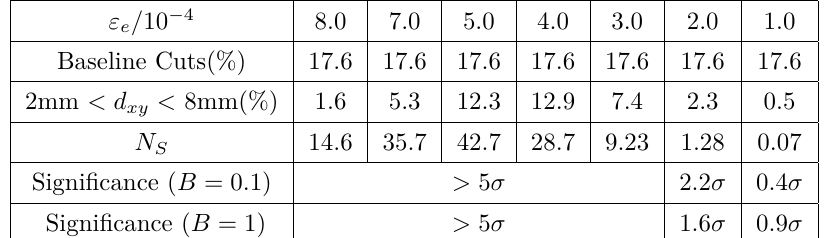
at Belle II and the e + e − → X + J/ Ψ cross